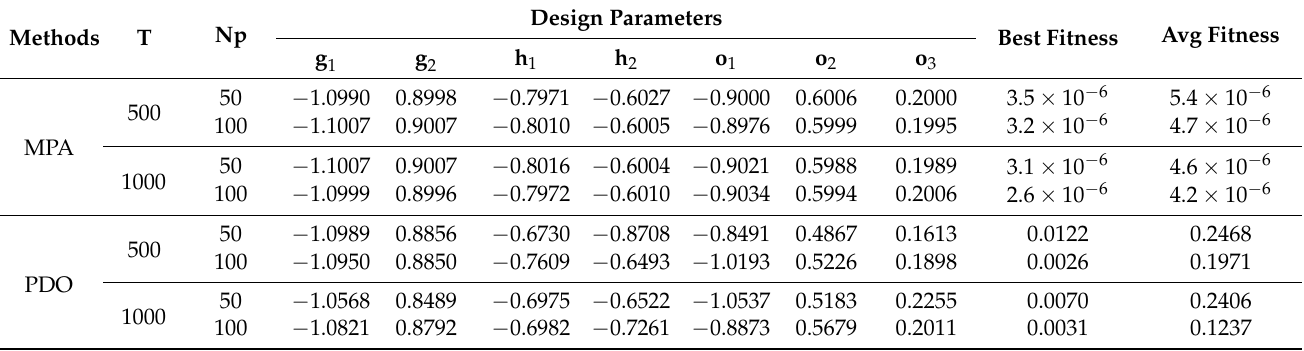
Table 3. Estimated weights analysis w.r.t generation and population sizes at 50 dB noise for case study